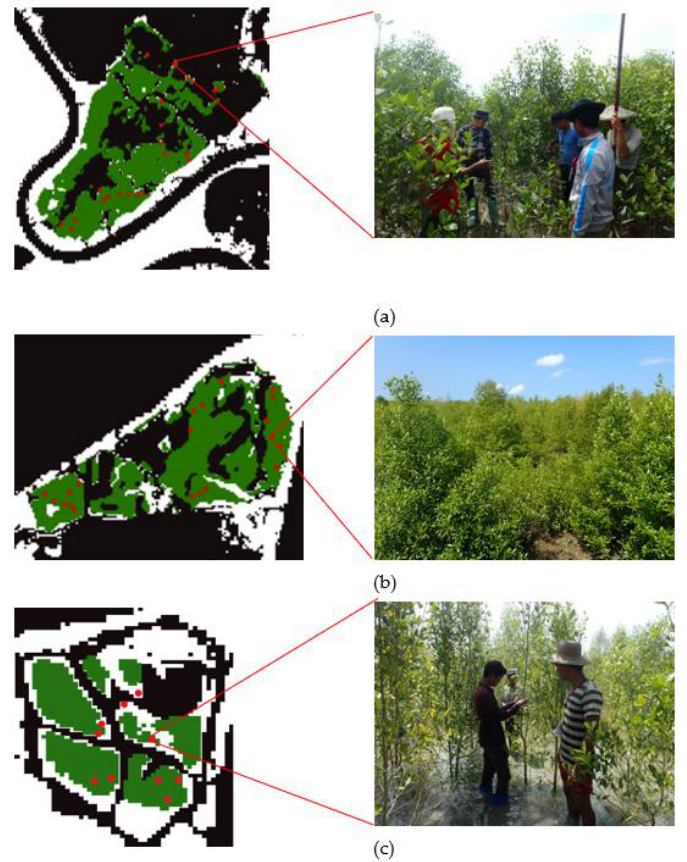
Figure 17. Ground checked photos of naturally recovering mangrove species at ( a ) Site 1 dominating Avicennia officinalis , ( b ) Site 2, and ( c ) Site 3 dominating Avicennia marina .